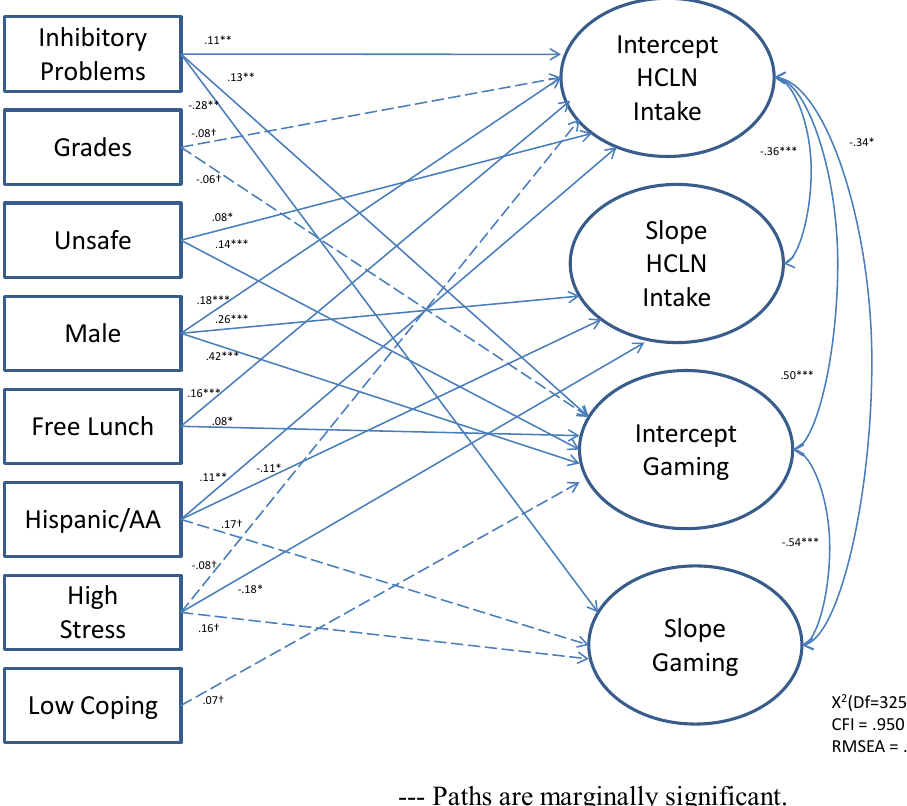
--- Paths are marginally